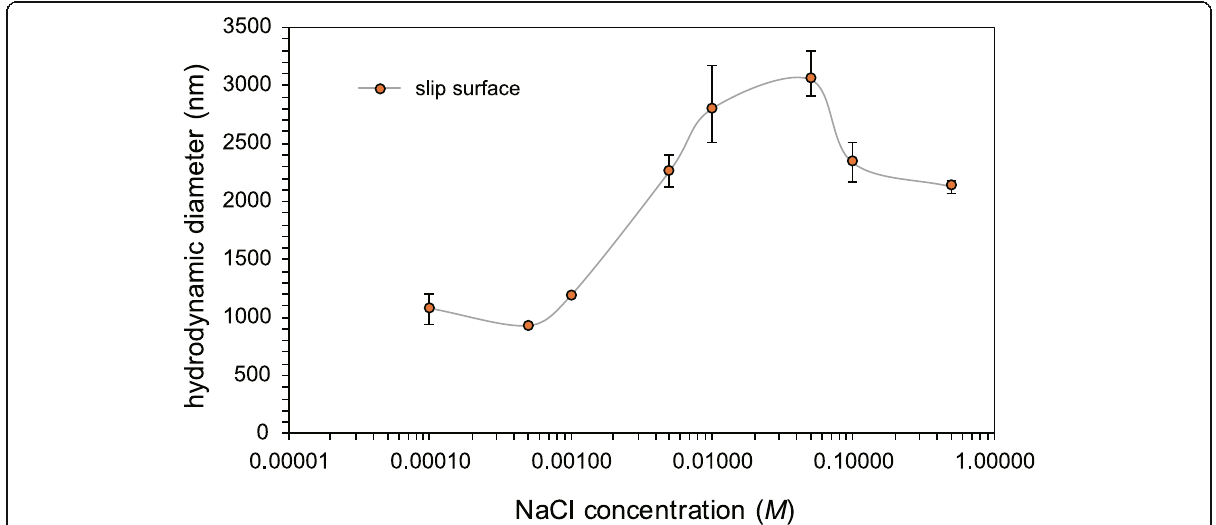
Fig. 9 Hydrodynamic diameter of particles (nm). The diameter was measured by dynamic light scattering as a function of solute concentration. Error bars denote the range of three repeated